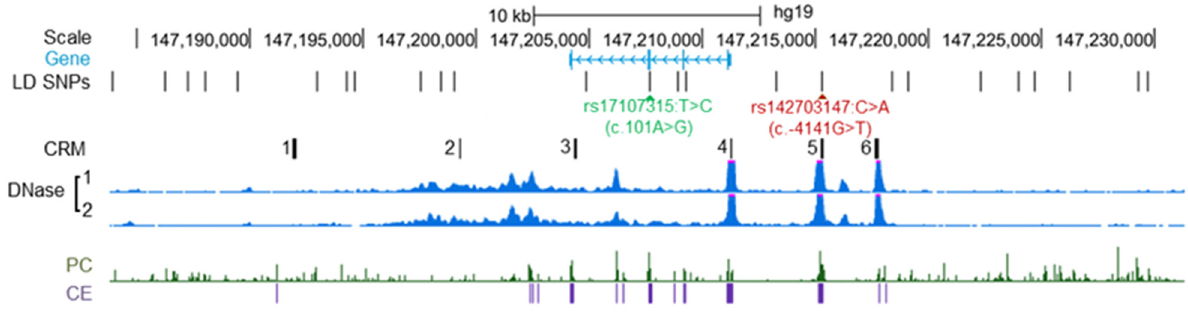
Figure 2. Illustration of the SPINK1 locus, the locations of the SPINK1 N34S (c.101A>G; rs17107315:T>C) and c.-4141G>T (rs142703147C>A) variants, and the spatial coincidence of c.-4141G>T with regulatory features. In the “Gene” panel, the four exons of the SPINK gene are denoted by vertical lines, with the arrows indicating the direction of transcription. LD SNPs, single nucleotide polymorphisms in strong linkage disequilibrium with SPINK1 c.101A>G. It should be noted that only 24 of the 25 LD SNPs are shown in the Figure, the variant that was not shown, rs138251740A>G (located further downstream of chr5:147,230,000), is neither located within a putative PTF1L − HNF1A CRM nor within a region showing strong evolutionary conservation and high chromatin accessibility. CRM, cis -regulatory modules harboring binding sites for transcription factors HNF1A and PTF1L. DNase, DNase I-accessible DNA regions in the pancreatic tissues of two donors as determined by DNase-seq. PC and CE, Placental Mammal Conservation by PhastCons (PC) and Placental Mammal Conserved Elements (CE) were obtained from the UCSC Genome Browser. The Figure was adapted from our work [18] with permission (Copyright 2021 Wiley Periodicals LLC).